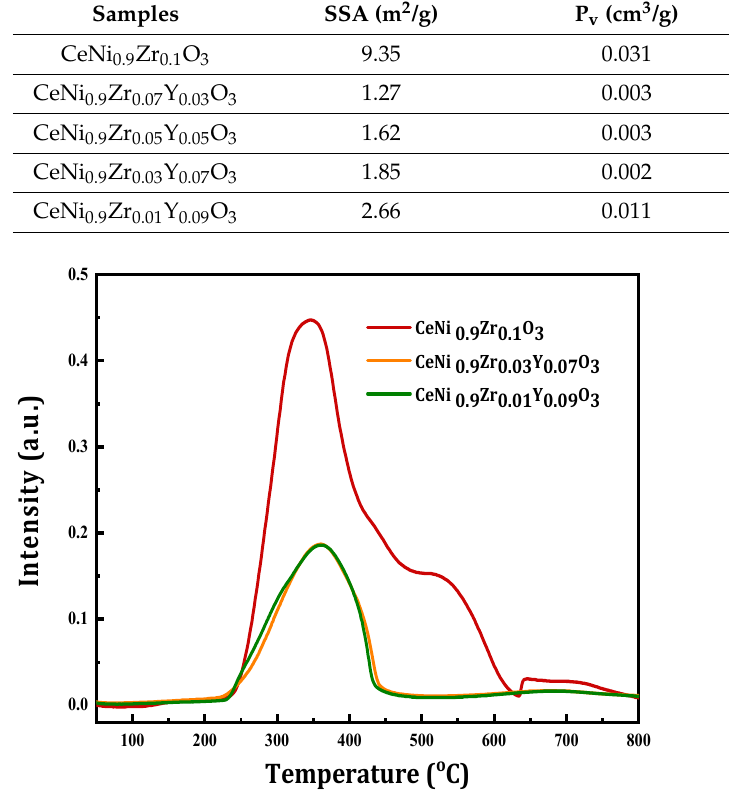
Figure 2. H 2 -TPR profiles of perovskite catalyst CeNi 0.9 Zr 0.1 − x Y x O 3 (x = 0, 0.07 and 0.09).